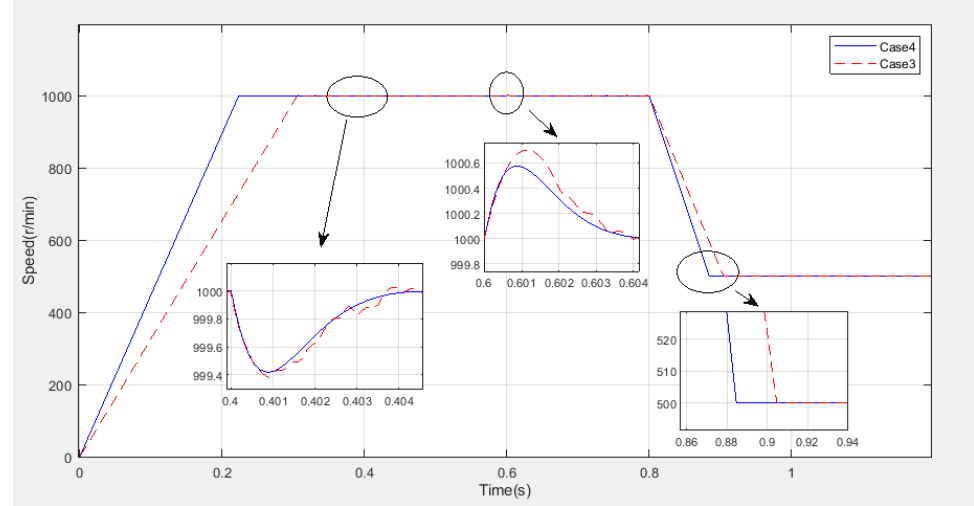
Figure 4. The speed response in Case 3 and Case 4.